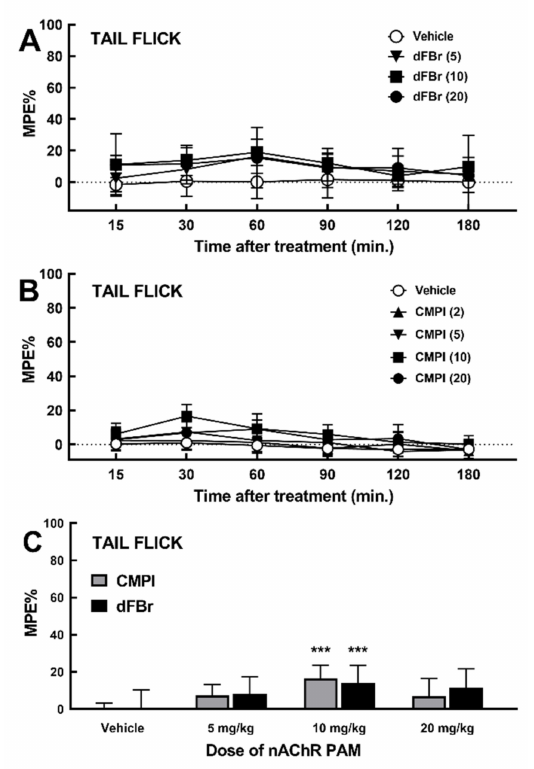
Figure 3. ( A , B ) Time course of the e ff ects of increasing dose of dFBr and CMPI, respectively, on acute thermal nociception in the tail flick test. Rats were pretreated with i.p. injection of vehicle, dFBr (5, 10, or 20 mg / kg) or CMPI (5, 10, or 20 mg / kg), then subjected to the tail flick after 15, 30, 60,